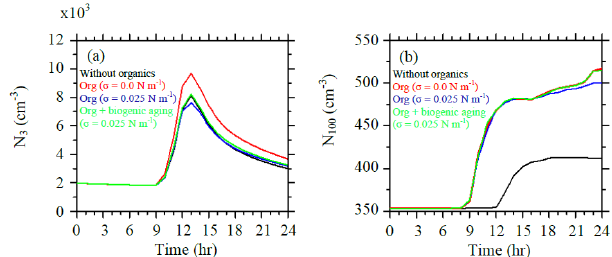
Figure 6. (a) Mass fraction of fresh particles and (b) mass fraction of SOA for the different volatility bins as a function of local time at Finokalia. Simulation includes bSOA aging and σ = 0.025Nm − 1 .